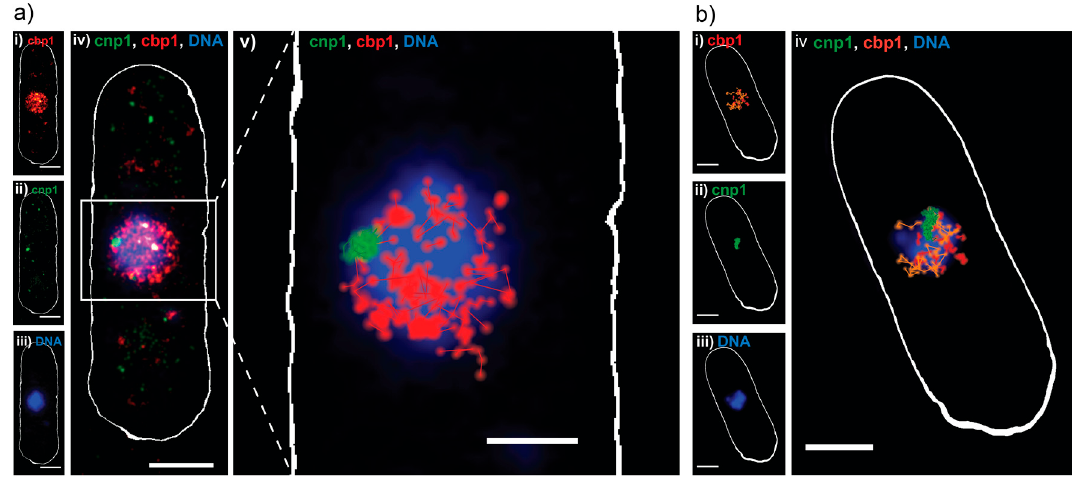
Figure 3. Sequential dual-color PALM on S. pombe . ( a ) Dual-color PALM image of a representative S. pombe cell, expressing the DNA binding protein cbp1 tagged with Dendra2 (red) and the centromeric protein cnp1 tagged with PAmCherry (green) and a widefield fluorescence image of DAPI stained DNA (blue): ( i – iii ) Split channels of the same cell and ( iv ) combined; ( v ) single particle track analysis performed on the same data, with tracks ≥ 3 consecutive frames represented in red (cbp1) and green (cnp1), on top of DNA (blue). Scale bars 2 μ m; ( b ) single particle tracking analysis done on a different S. pombe cell: ( i ) single particle tracks of cbp1 ≥ 4 consecutive frames, color coded for their apparent diffusion coefficient D as calculated from a MSD analysis of the individual tracks, orange for fast moving particles (D > 0.26 μ m 2 /s) and red for slow or immobile (D < 0.26 μ m 2 /s); ( ii ) single particle tracks of cnp1 ≥ 4 consecutive frames; ( iii ) widefield fluorescence image of DNA in the same cell, after fixation; ( iv ) overlay of all three channels. Scale bars 2 μ m.